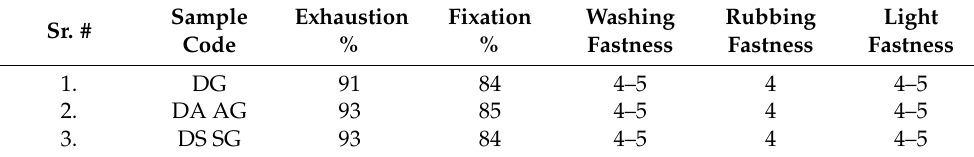
Table 5. Exhaustion, fixation, and fastness (washing, rubbing, and light) results of dyed